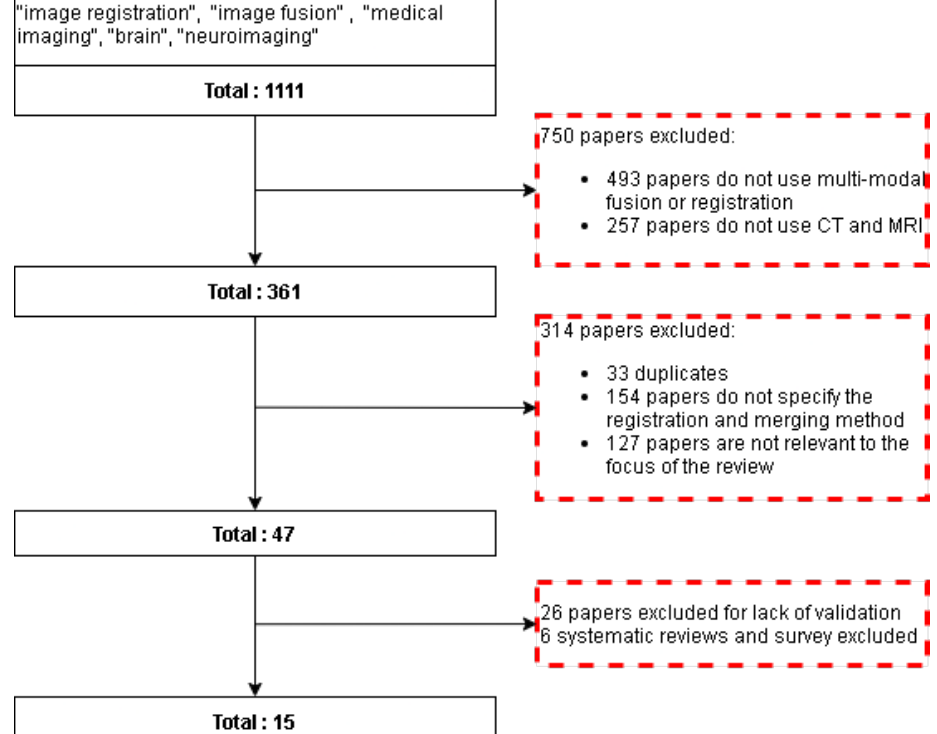
Figure 2. Flow diagram for the literature review. Red dotted squares represent the excluded